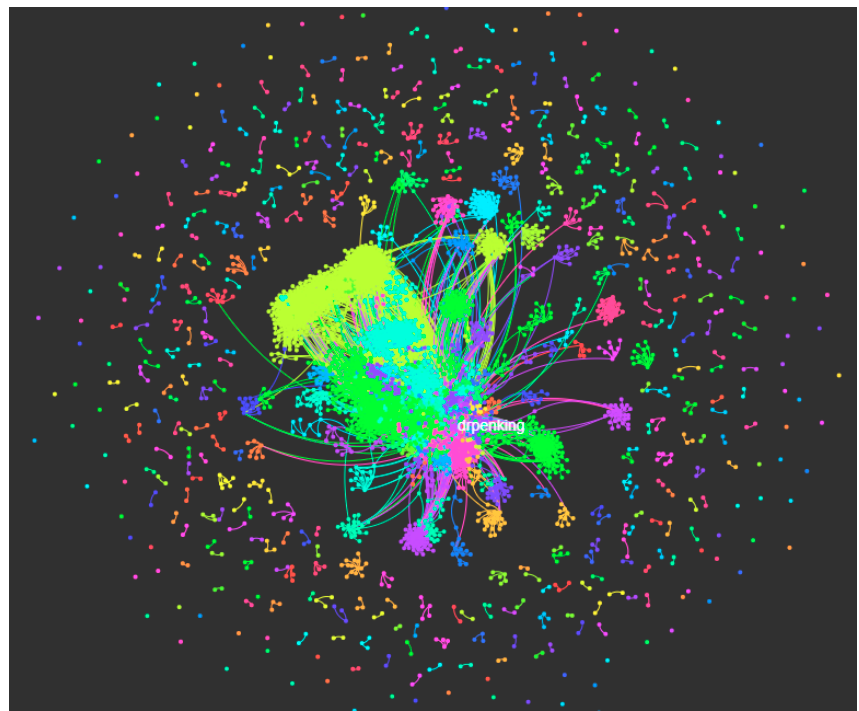
Figure 3. Network visualisation of tweets relating to #EndSARSMemorial2.